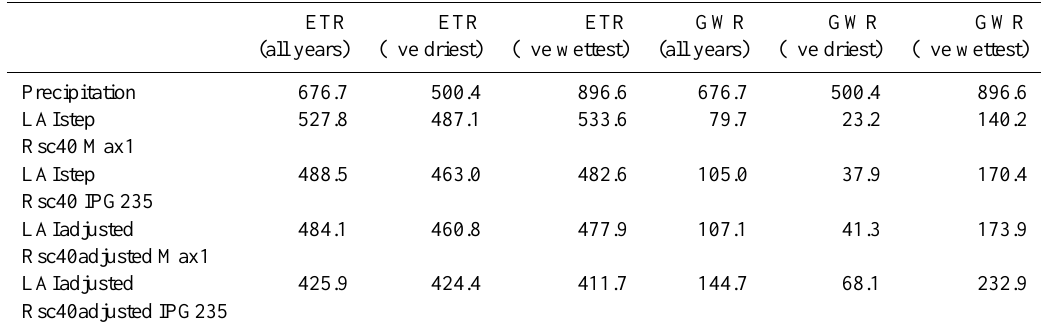
Table 5. Precipitation (mmyr − 1 ) , total evapotranspiration (ETR) and ground water recharge (GWR) for the period 1969–2013. Simulations are shown for the step-function simulation and the adjusted course for leaf area index and stomatal resistance, using the leaf unfolding (LU) according to the Max1 and IPG235 parameter set for simulating LU. The parameterisation for poplar is equal to that derived for 2013 for the whole period, i.e. the same vegetation hydrological modelled driven by different weather conditions. Values are summed up for all years (1969–2013) of the period and for the five driest and five wettest years, respectively. ETR ETR ETR